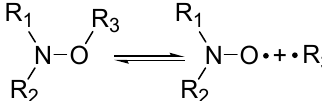
Figure 1. Timeline of the discoveries of the variants of NMP